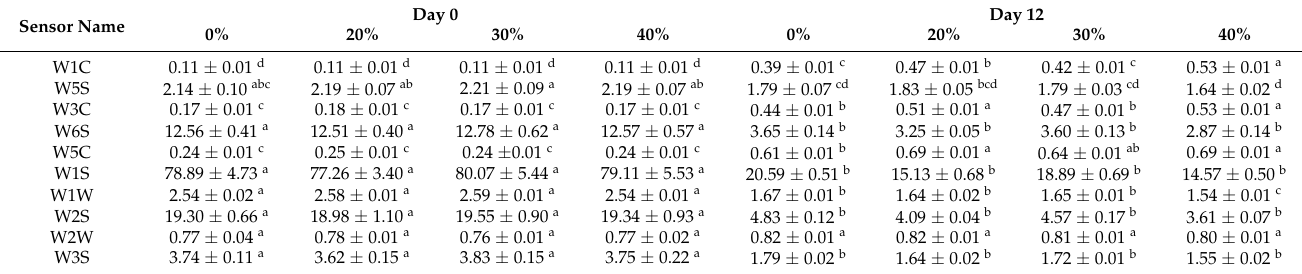
Table 2. Response values of electronic nose sensors of traditional dry sausage with different KCl substitution ratios at day 0 and day